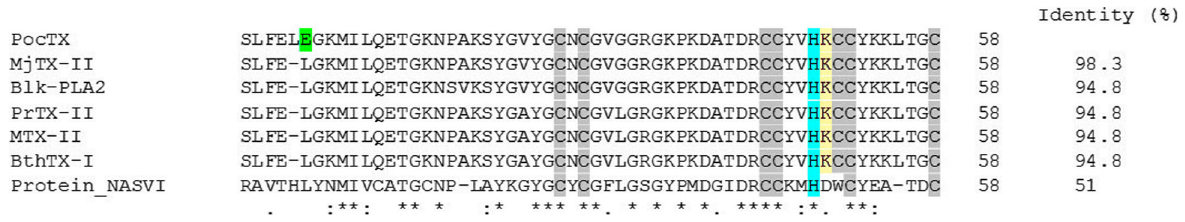
Fig. 3 Multiple alignment of the N-terminal sequence of PocTX. After sequencing by Edman degradation (10 μ g), the sequence was compared to other snake venom PLA 2 homologues, including Bothrops moojeni (PA2H2_BOTMO, ID: Q91834), Bothrops leucurus (PA2HB_BOTLC, ID: P86975), Bothrops pirajai (P2H2_BOTPI, ID: P82287), Bothrops asper (PA2H2_BOTAS, ID: P24605) and Bothrops jararacussu (PA2B1_BOTJR, ID: Q90249), and to an uncharacterized protein from the parasitoid wasp Nasonia vitripennis (NASVI_NASVI, ID: K7JAT1). In green, the insertion of a glutamic acid residue in PocTX ’ s sequence; in blue, a histine residue at position 48; in yellow, a lysine residue at position 49; and in gray, conserved cysteine